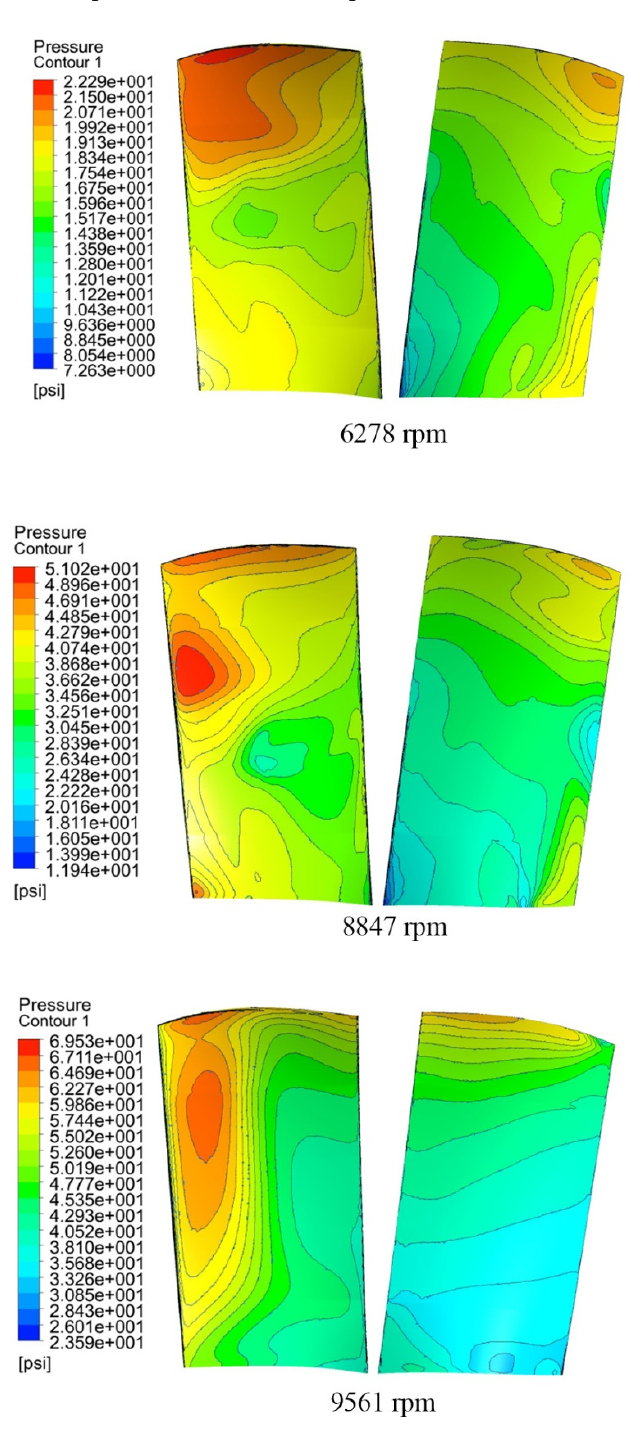
Figure 8. Aerodynamic pressure comparison of blade at 6278, 8847 and 9561 rpm.